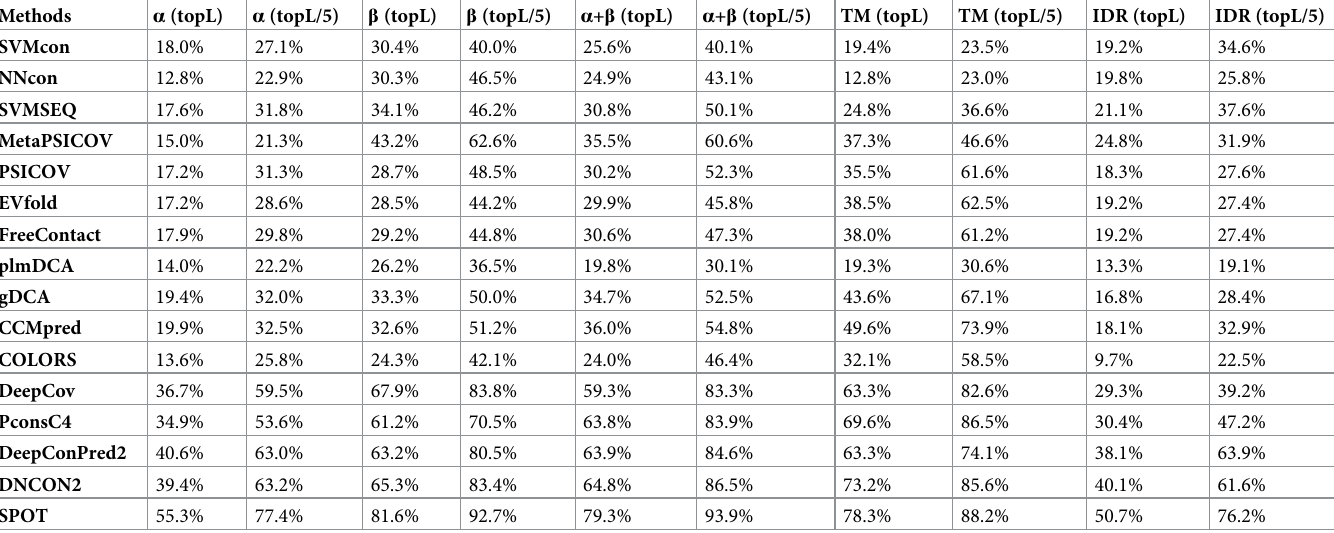
Table 1. Prediction precisions of top L, L/2 and L/5 all-range predictions by 16 methods on different protein types with N eff > 0